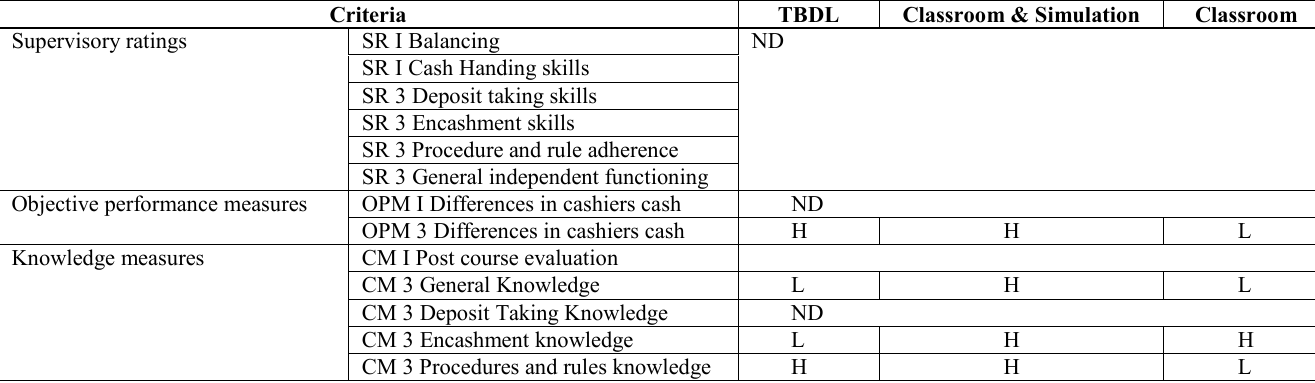
Table 6: Summary of